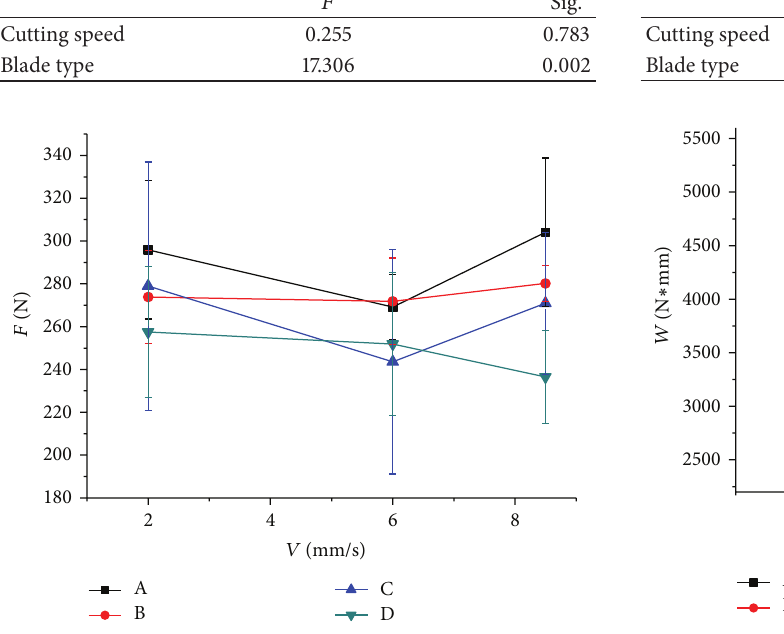
Figure 7: Experimental results of the maximum soil-cutting resis- tance.